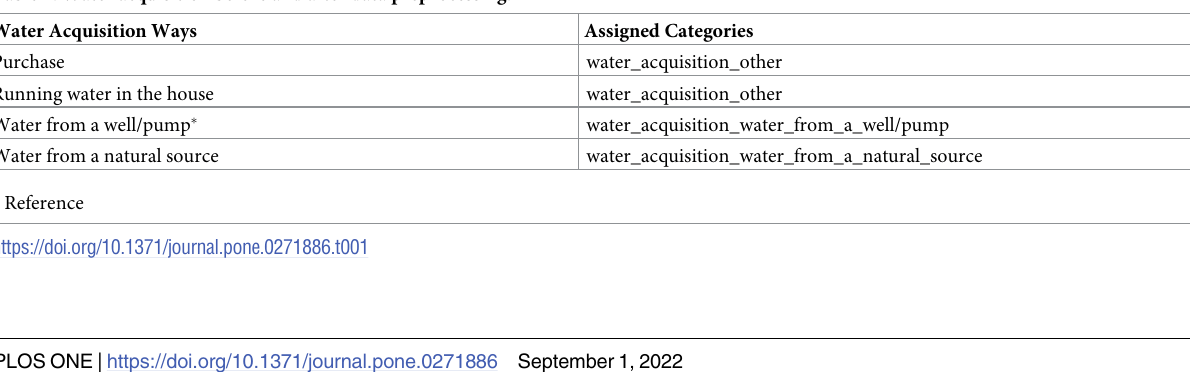
Table 1. Water acquisition before and after data